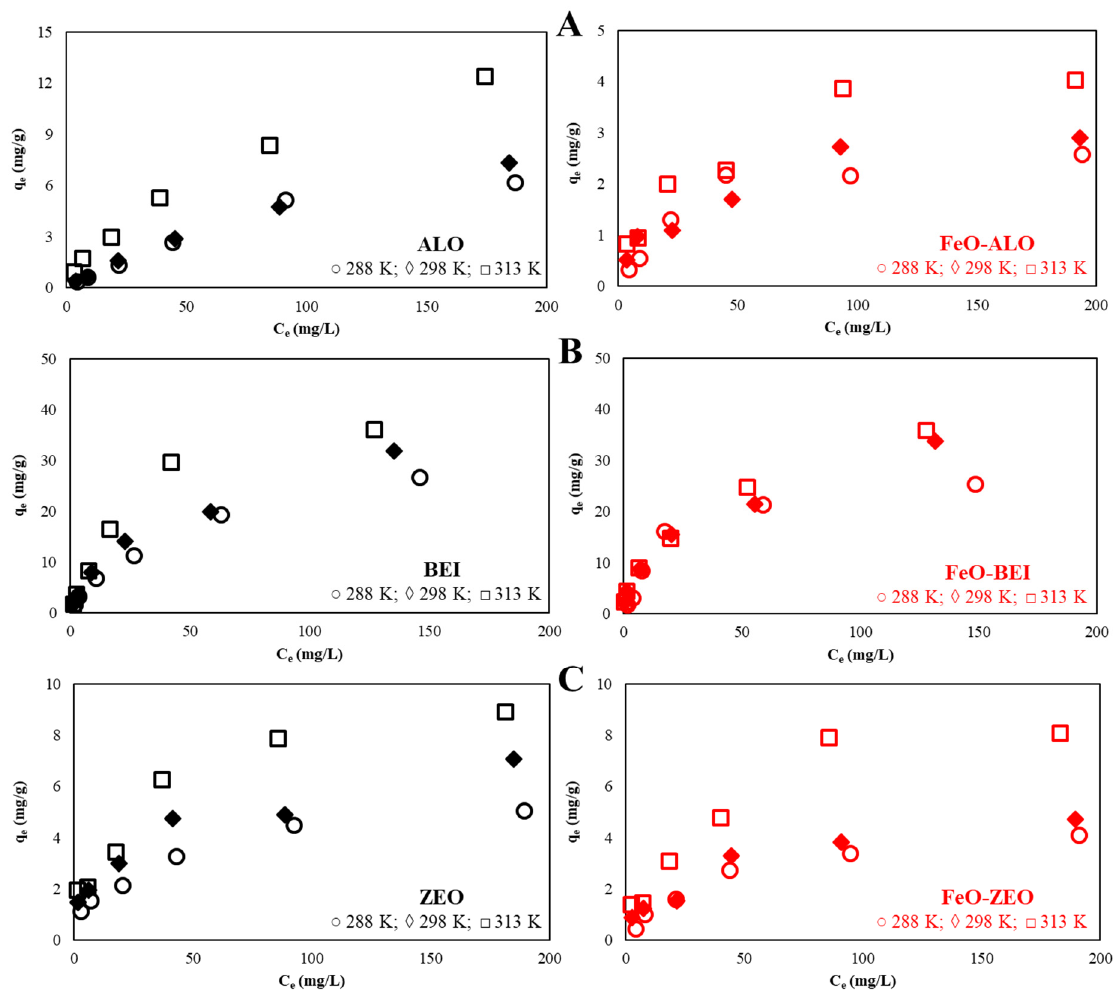
Figure 9. Adsorption isotherms (operational conditions: 283–313 K, pH 6.0, adsorbate / adsorbent ratio: 500:1, 5–200 mg / L Ba) for natural and FeO-modified ALO ( A ), BEI ( B ) and ZEO ( C ). Symbols are larger than the analytical uncertainty.